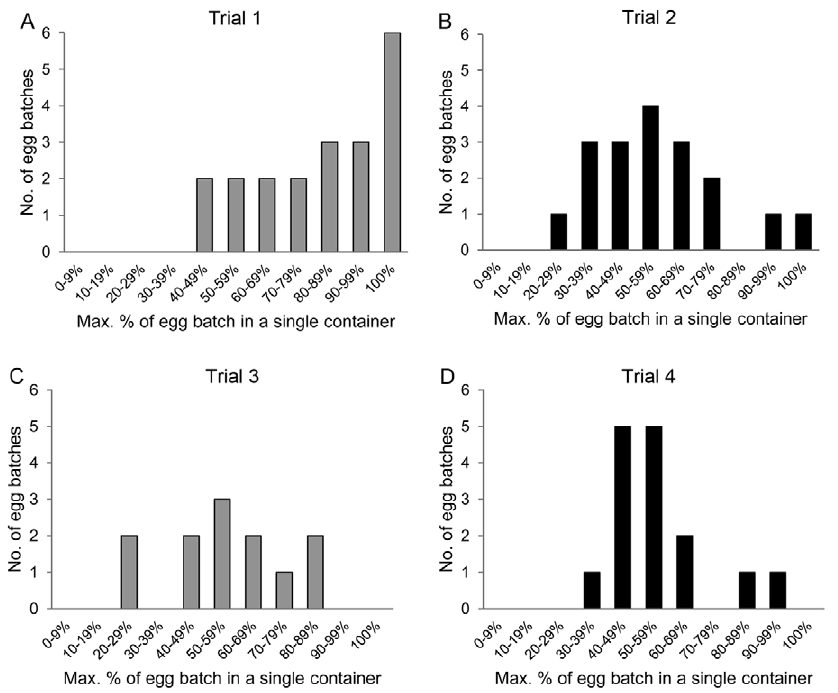
Figure 7. Concentration of eggs within a single container. Within the enclosure, the frequency distribution for the maximum proportion of each egg batch concentrated in any single container is shown for: A) trial 1 (pre-intervention), B) trial 2 (post-intervention), C) trial 3 (pre-intervention), and D) trial 4 (post-intervention). Preferred (large unmanaged) containers were available during pre-intervention trials (denoted by grey bars) but not during post-intervention trials (denoted by black bars).